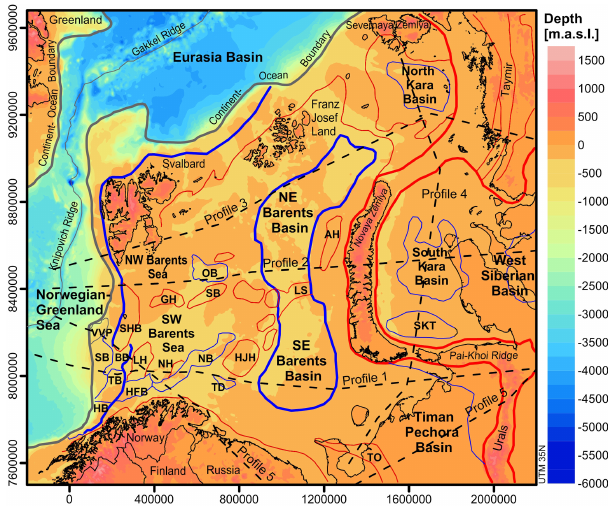
Figure 1. Superimposed bathymetry/topography (IBCAO 3.0; Jakobsson et al., 2012) with outlines of structural highs (red) and lows (blue). The stippled lines mark the position of five repre- sentative profiles (see Fig. 6) crossing most prominent geologi- cal provinces. (AH) – Admiralty High; (BB) – Bjørnøya Basin; (GH) – Gardarbanken High; (HFB) – Hammerfest Basin; (HB) – Harstad Basin; (HJH) – Hjalmar Johansen High; (LH) – Loppa High; (LS) – Ludlov Saddle; (NB) – Nordkapp Basin; (NH) – Norsel High; (NSW) – North Siberian Weir; (OB) – Olga Basin; (SB) –Sørvestsnaget Basin; (SKT) – South Kara Trough; (SHB) – Stappen High with Bjørnøya Island; (TD) – Tiddlybanken Basin; (TO) – Timan Orogen; (TB) – Tromsø Basin; (VU) – Vize-Ushakov Rise; (VVP) – Vestbakken Volcanic